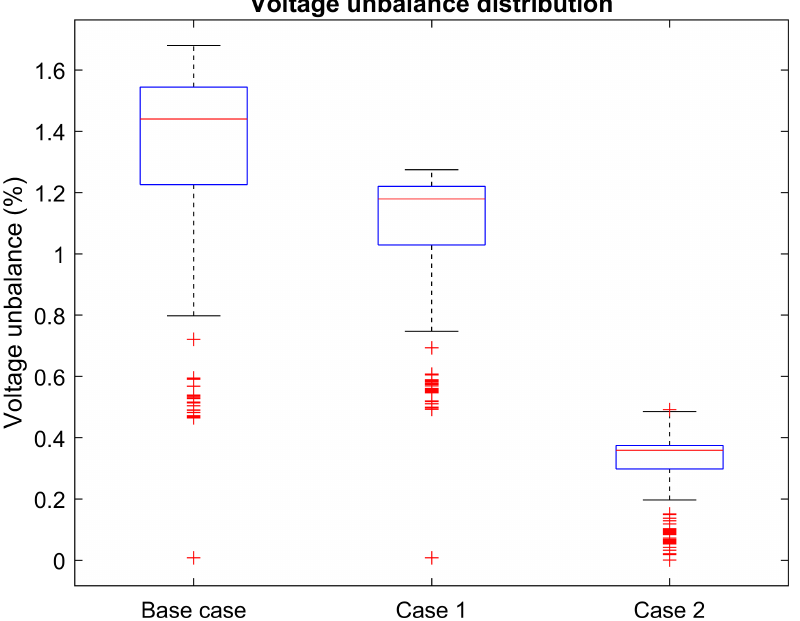
Figure 21. Voltage unbalance distribution of base case, Case 1 with IPPF control, and Case 2 with IPPF control and PF